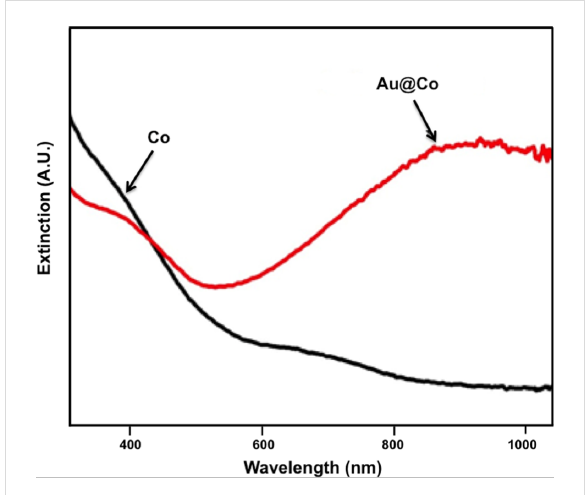
Figure 7: Extinction spectra of (a) Co nanoparticles and (b) Au@Co nanochains.